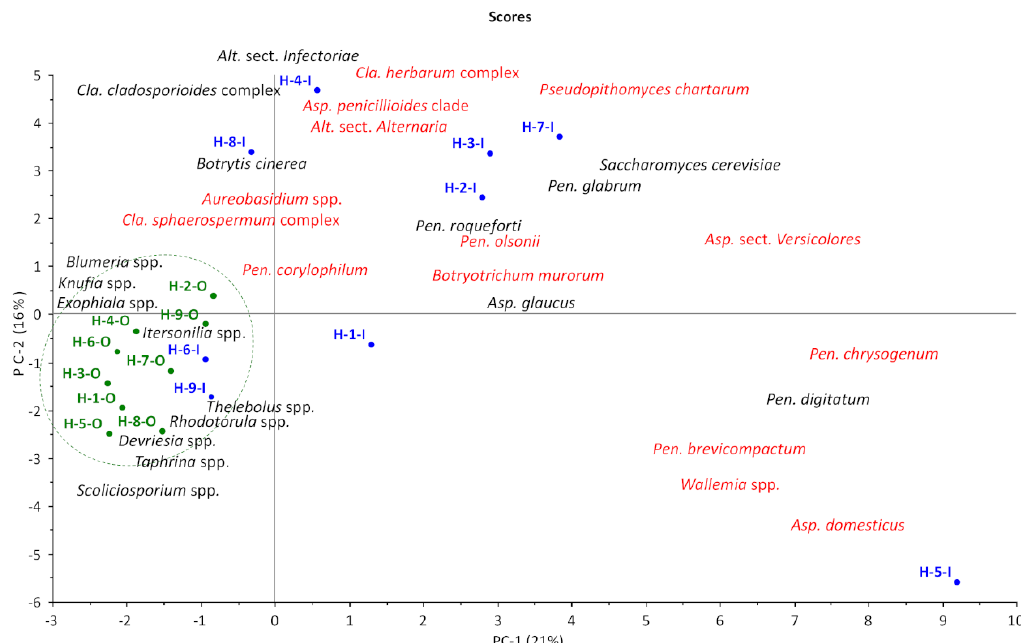
Figure 1. Score plot from a PCA (18 × 41) based on the 9 homes (H) (indoors (I) in blue and outdoors (O) in green) and 41 of the most common fungal genera and species. Selected fungal genera and species have been transferred from the biplot. Fungal species in red are humidity indicator fungi. The plot axes PC-1 and PC-2 are principal components with arbitrary score values. Alt.: Alternaria; Asp.: Aspergillus; Pen.: Penicillium. Cladosporium species as complexes ( Cla . herbarum